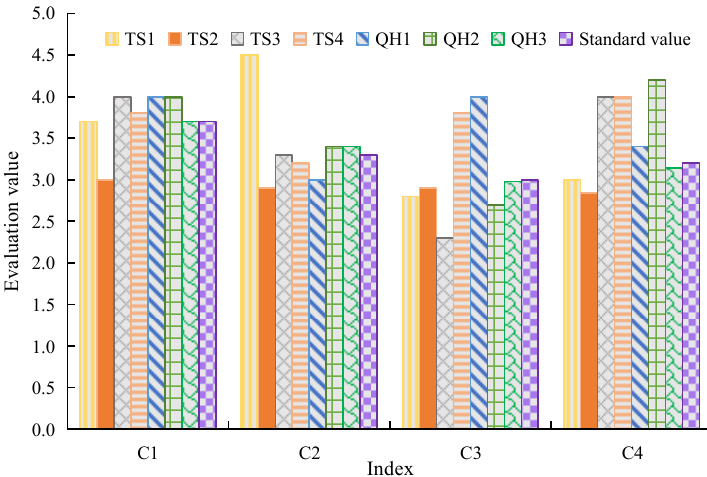
Figure 5. Building Evaluation Map of Seven Kailuan System Projects.